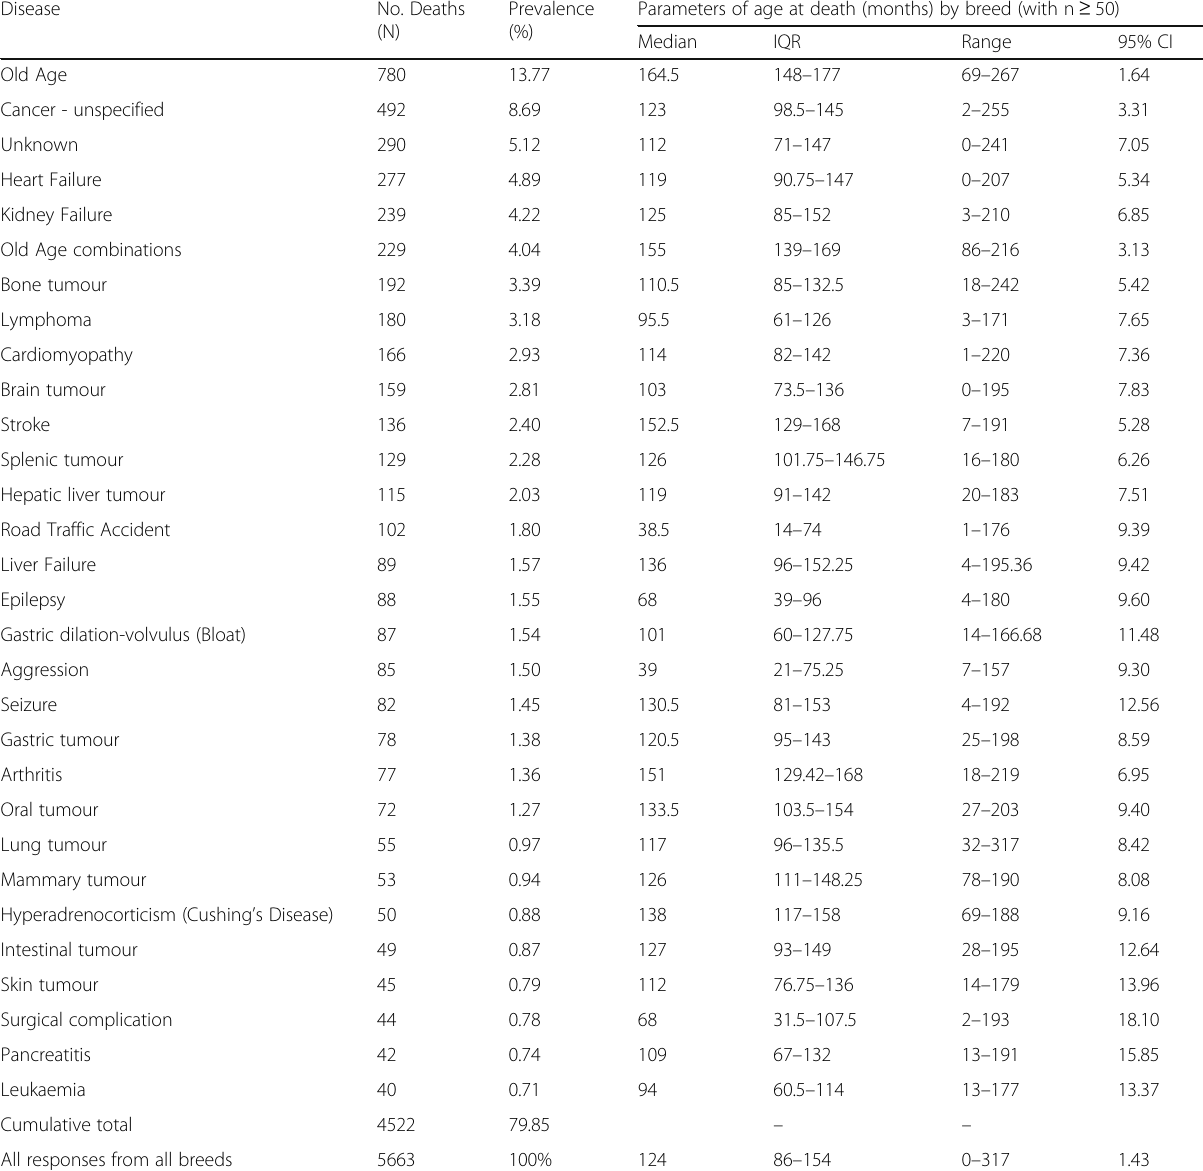
Table 2 Age at death statistics from the 30 most commonly reported causes, including the number of deaths reported (N), the contribution per cause (as a percentage of all deaths reported in the survey), the median, inter-quartile range (IQR), range (minimum and maximum) and 95% confidence interval of the median of age of death in